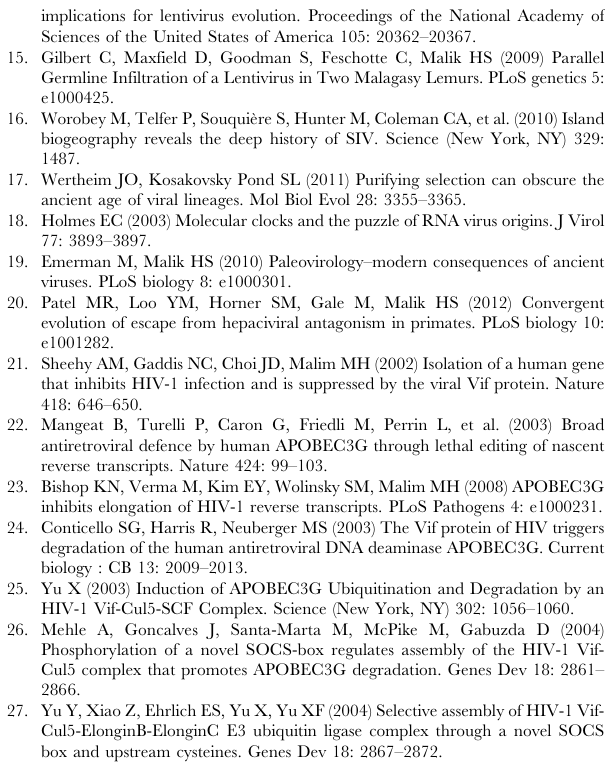
Figure S2 Protein alignment of OWM A3G. A3G nucleotide sequences from OWM species, including intraspecies variants detected for some species, were aligned in ClustalW and translated to amino acid code. Residues that meet or approach the threshold for diversifying selection, as detected by MEME analysis, are highlighted in green. Gaps removed for evolutionary analysis have been restored, and codon numbering corrected to reflect positioning in AGM A3G. Figure S3 SIVolc Vif antagonizes colobus A3G. (A) Single- round infectivity assays were performed with HIV-1 D Vif and HIV-1 expressing SIV Vif proteins produced in the presence of AGM haplotype I A3G or Colobus A3G. Error bars indicate standard deviation from the mean of three infection replicates. SIVolc Vif, but not Vif from other characterized isolates of SIV that infect Colobinae hosts, overcomes restriction by A3G of the mantled colobus ( Colobus guereza ). (B) Anti-HA and anti-FLAG western blot analysis were used to measure expression of A3G and Vif in virus producing cells, respectively. Note that expression of Vif from SIVcol, the species-specific lentivirus of the mantled colobus monkey, was not detected. SIVwrc Vif was expressed, but demonstrated no activity against colobus A3G. Table S1 Comparison of results from selection models implemented in Codeml. A comparison of M7 and M8 models, assuming the F3x4 codon frequency model and an initial v value of 0.4, was used to identify individual residues of A3G undergoing positive selection. Runs using alternative codon frequency models (F1x4 and codon table), and alternative selection models (M1 and M2) generated similar results. M7 and M8 allow the dN/dS values for each site to vary according to a beta distribution, but M8 allows for dN/dS values greater than 1